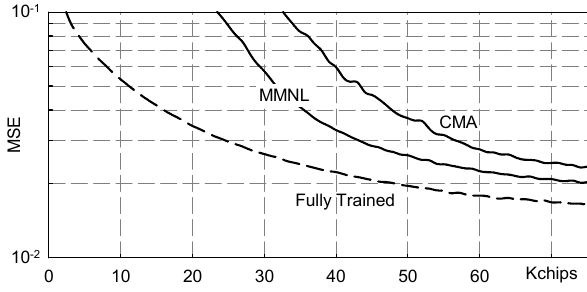
Figure 10. MSE vs. transmitted chips: channel (21), NSR = 20 dB.